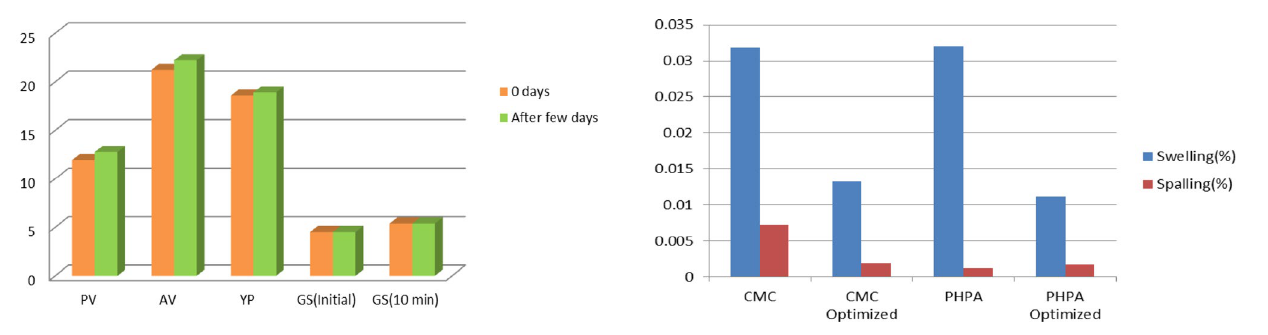
Fig. 30 Figure 83: rheological properties of optimized PHPA–ben- tonite mud in accordance with time